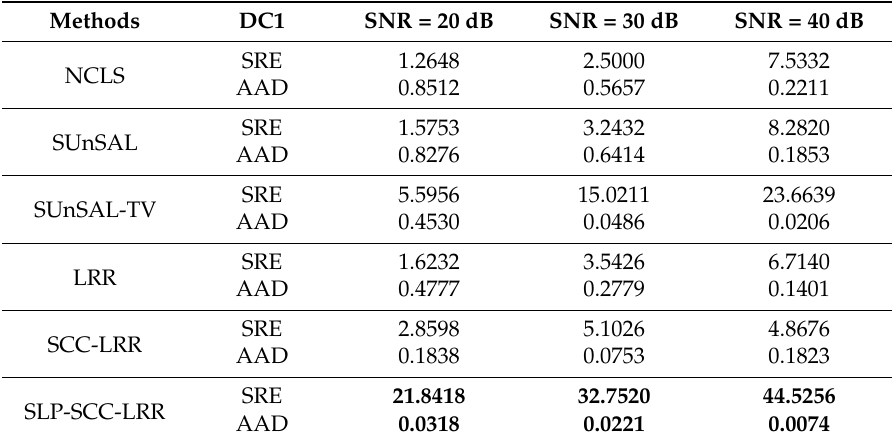
Table 1. SRE (dB) and AAD values achieved after applying different unmixing methods to Simulated DATA 1.